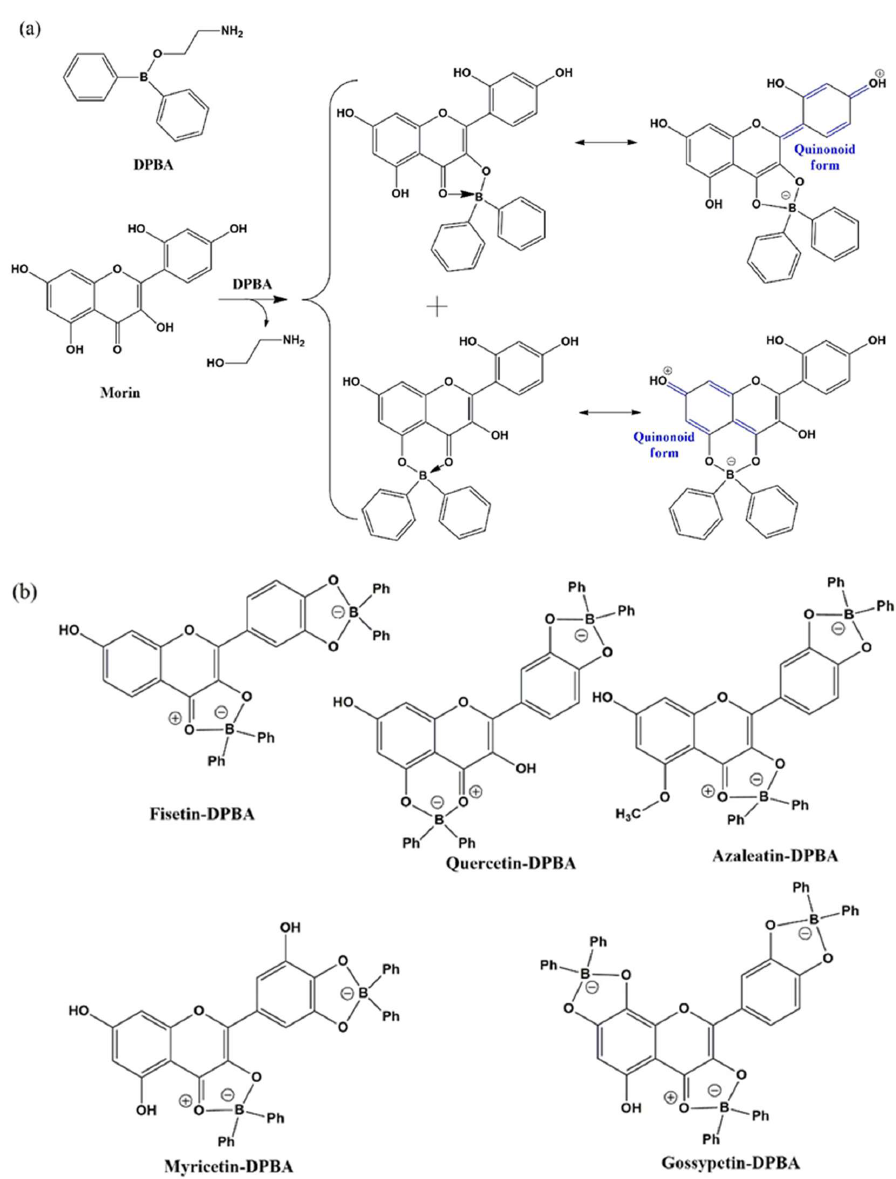
Figure 4. ( a ) A schematic presentation of the complexation of DPBA with morin and the plausible quinonoid forms. ( b ) The plausible molecular structures of complexes formed on treatment of fisetin, quercetin, azaleatin, myricetin and gossypetin with